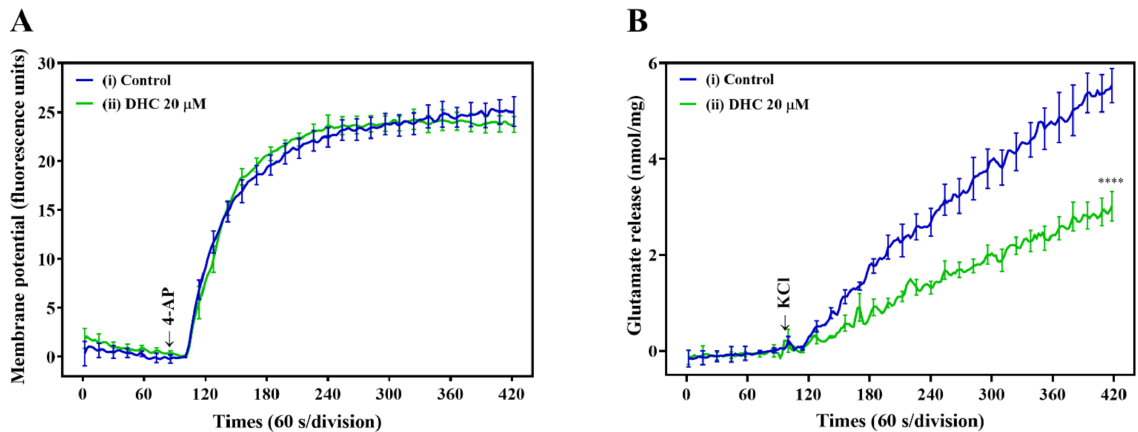
Figure 3. Influence of DHC on synaptosomal plasma membrane potential. ( A ) Response of the DiSC3(5) probe in synaptosome suspension to 4-AP depolarization. The arrow indicates the moment when depolarizing stimuli (4-AP 1 mM) were added to the synaptosome. The presented curve shows the results obtained in six independent measurements. ( B ) Synaptosomes were depolarized with 15 mM KCl, and the continuous release of glutamate followed. DHC (20 µ M) decreased KCl-evoked glutamate release from synaptosomes. **** p < 0.0001 versus the control group ( n = 5).